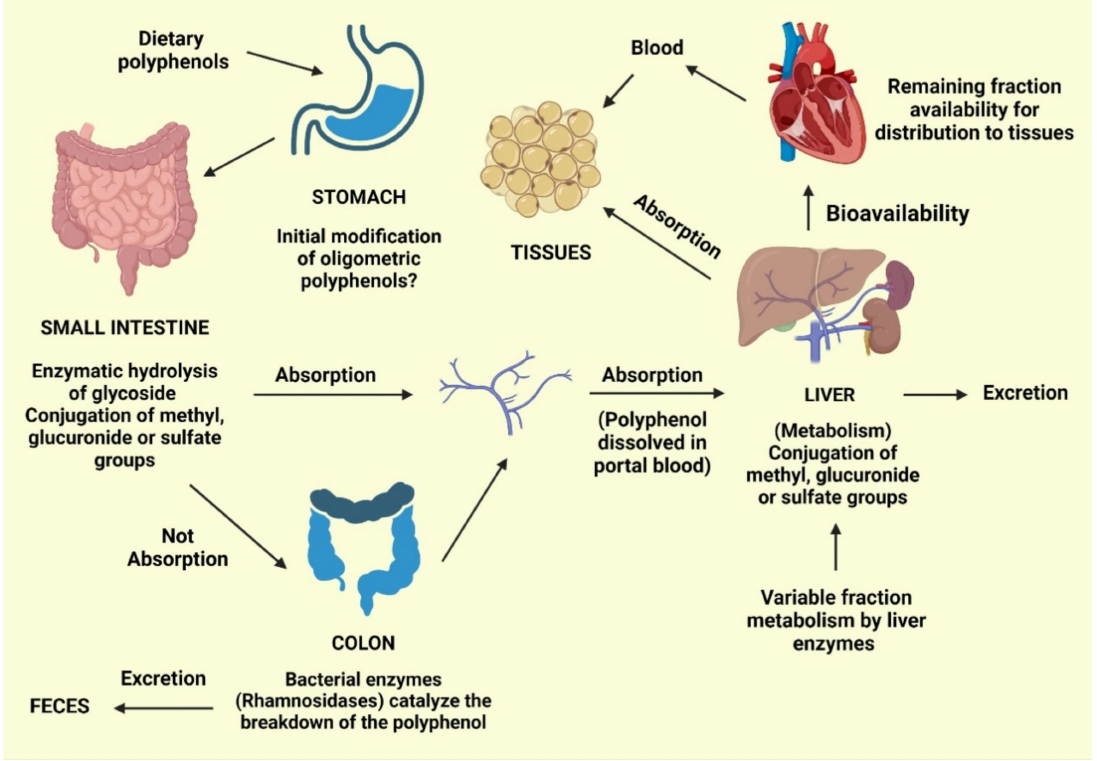
Figure 2. Predicted routes for the absorption of dietary phenolics